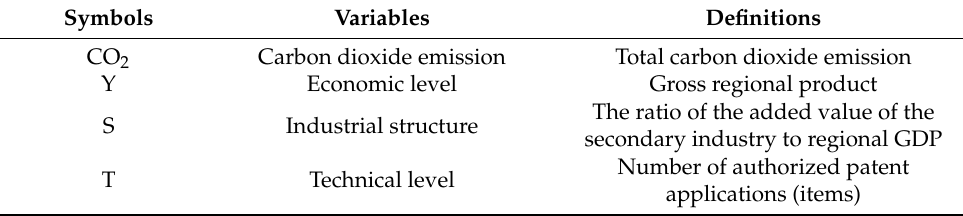
Table 2. Variables